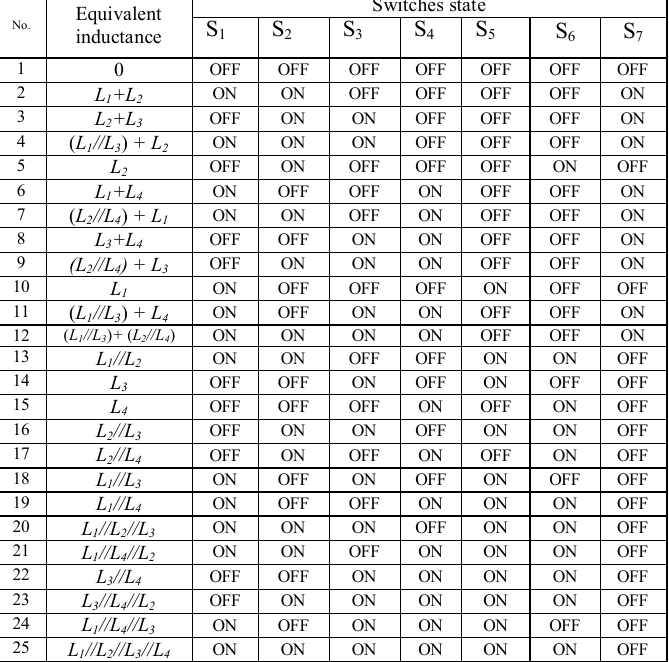
TABLE I. THE EQUIVALENT INDUCTANCE OBTAINED BY NEW TSR WITH FOUR REACTORS AND SEVEN SWITCHES